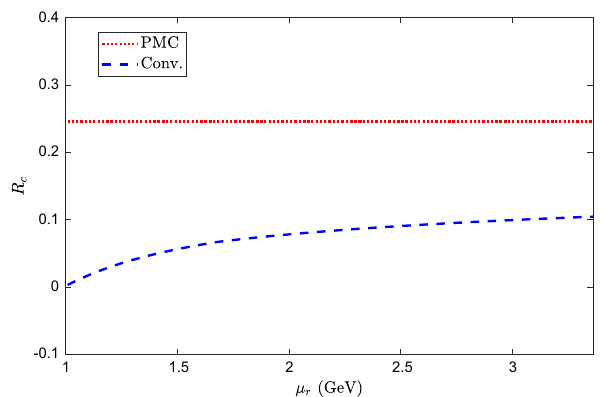
Fig. 2 The NLO order and NNLO order R c -ratios under conventional and PMC scale-setting approaches as a function of μ r . μ (cid:12) = 1 GeV